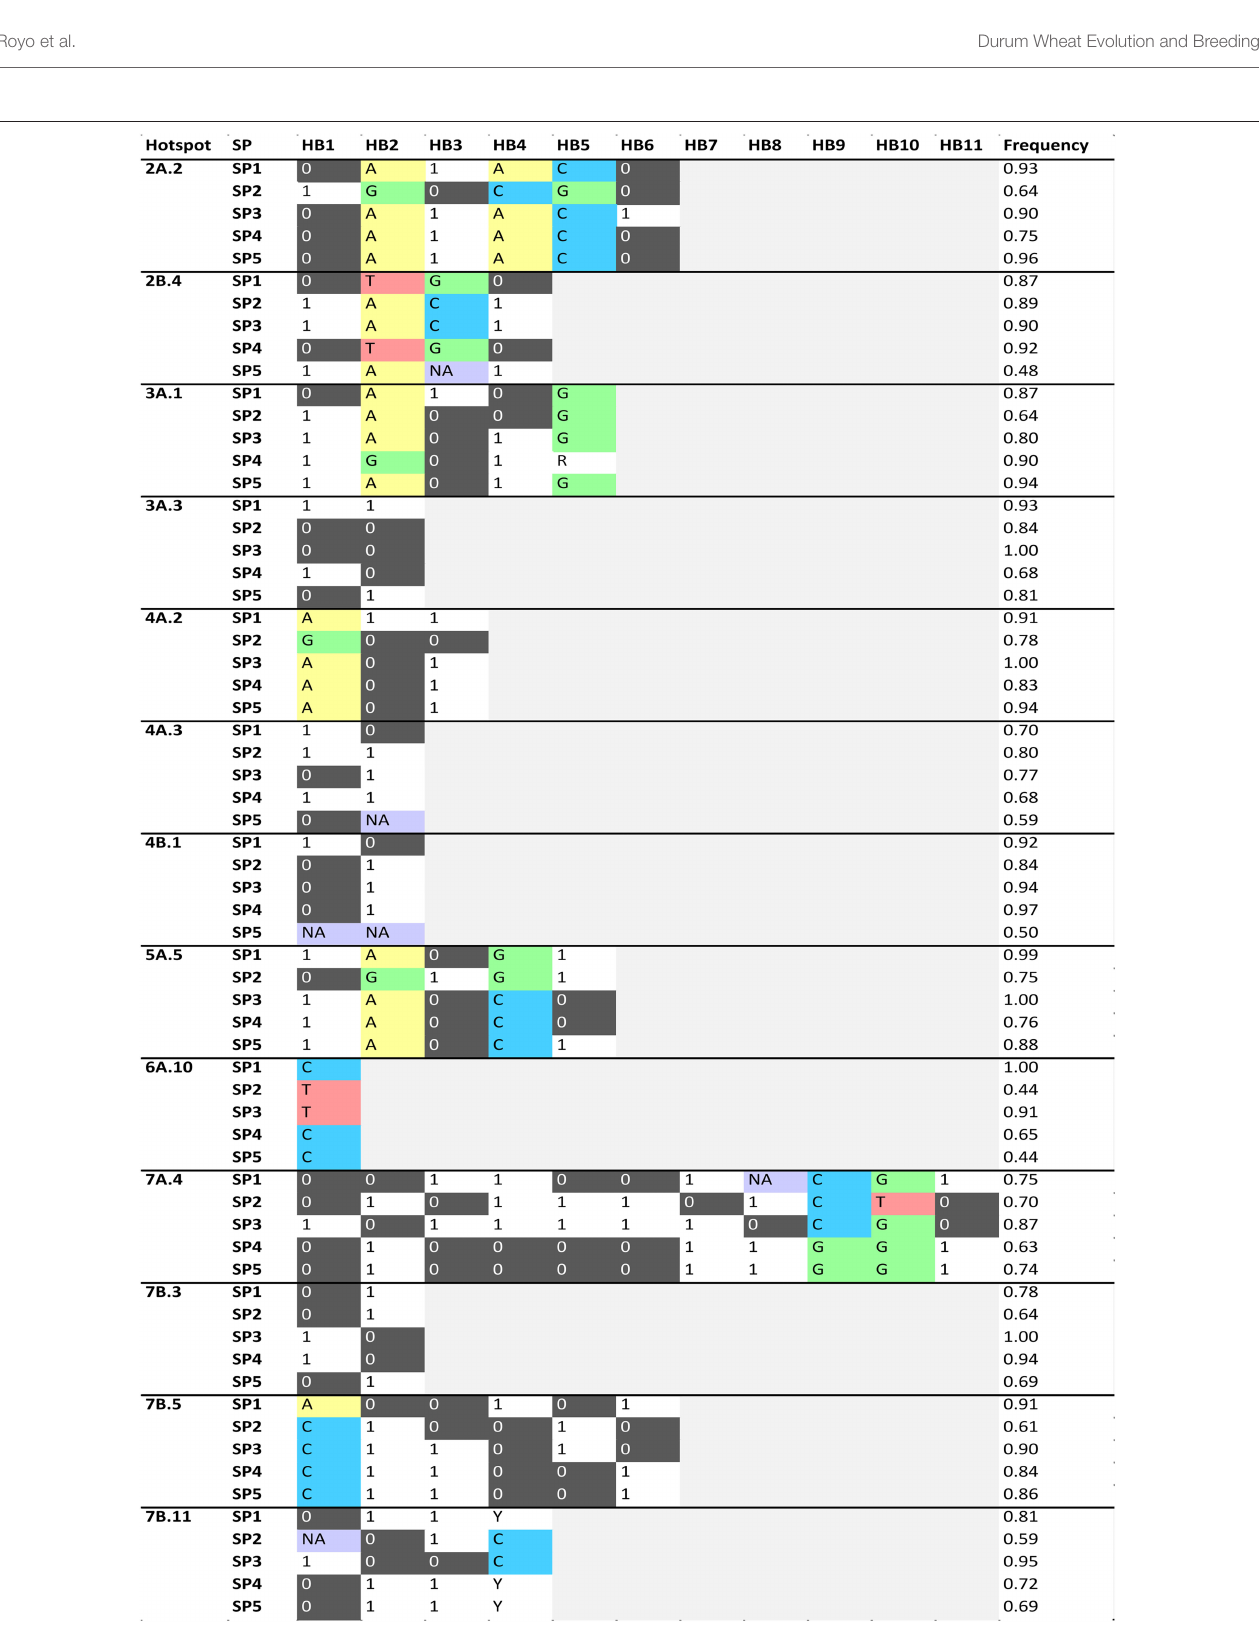
FIGURE 4 | Haplotype blocks (HBs) for each one of the QTL hotspots identified among 120 durum wheat modern and landrace genotypes. The frequency corresponds to the mean of the frequency of the major allele for each marker within each SP. NA: Frequency of the major allele lower than 60%. PAVs are codified as 1 (presence) or 0 (absence), and SNPs following the IUPAC